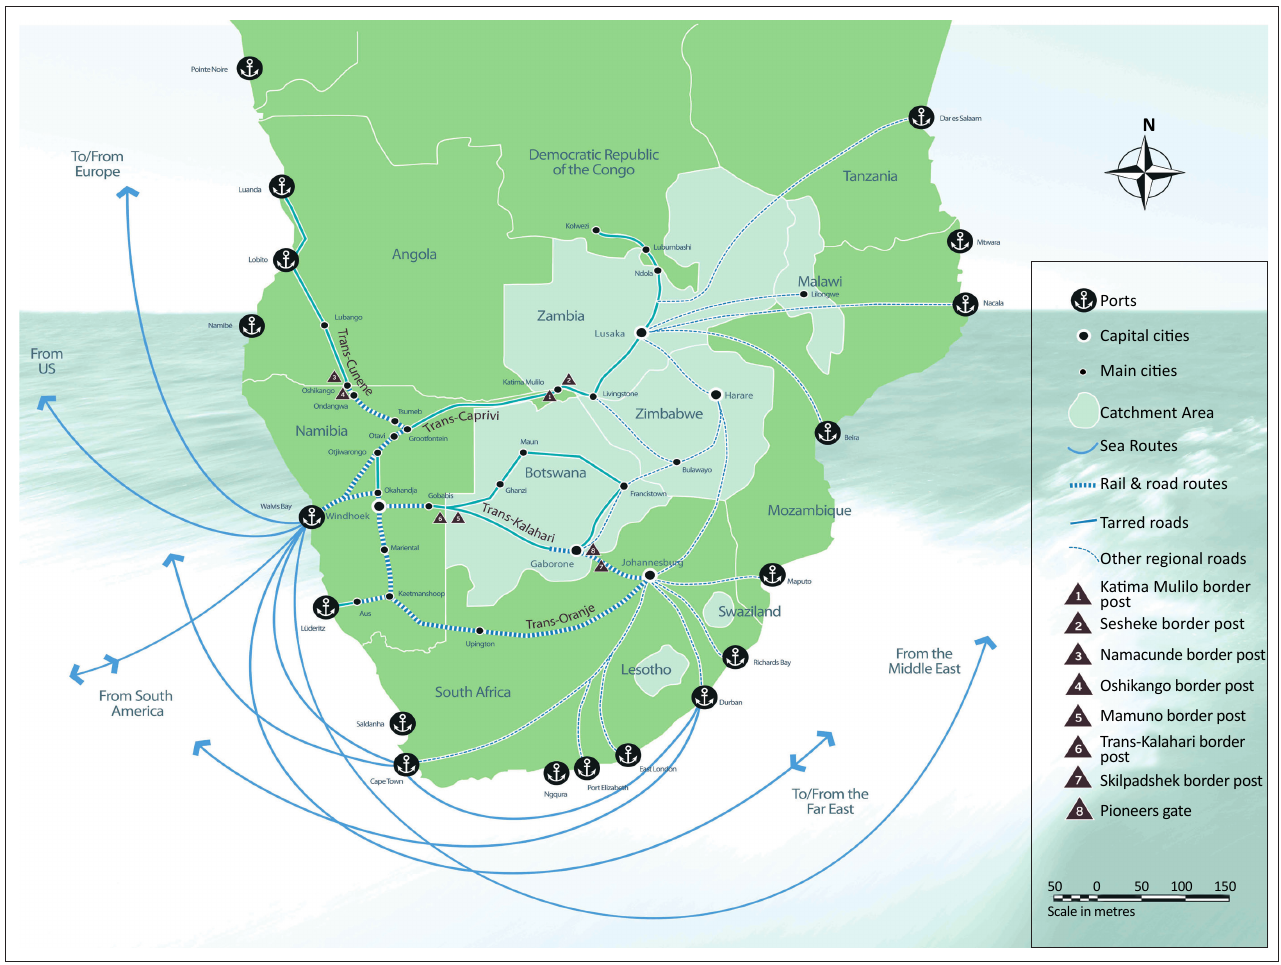
FIGURE 1: Map of southern Africa showing the main corridor routes.